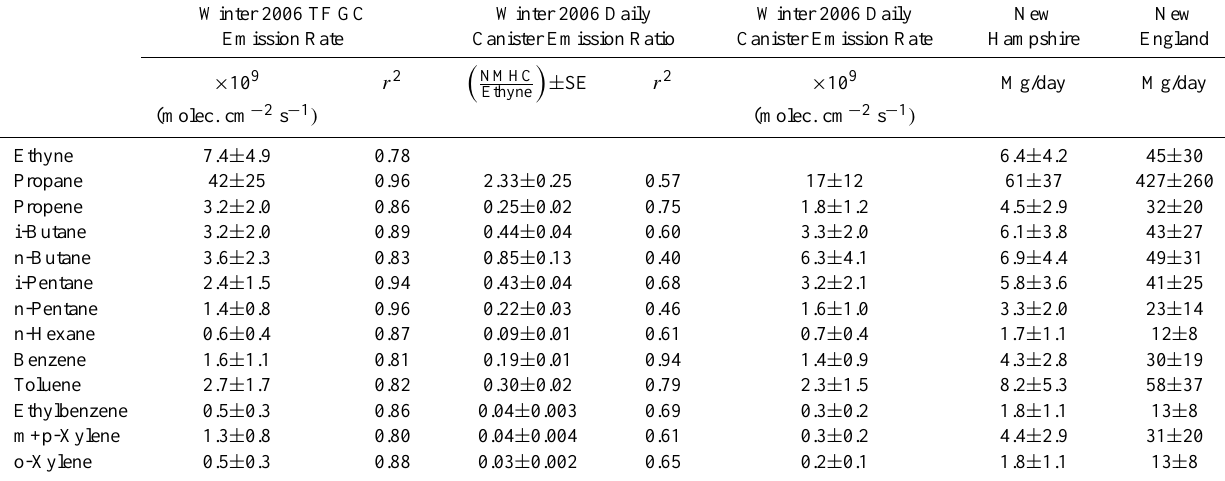
Table 3. Emission rates (moleculescm − 2 s − 1 ) of C 3 -C 8 NMHCs calculated using nighttime measurements made by the automated TF GC when a stable inversion layer developed during winter 2006. The error bars were calculated by propagating the standard error of the linear regression between the change in NMHC concentration per unit time (00:00–05:00EST) and the assumed variation in nocturnal boundary layer height (125m ± 75m). The winter 2006 daily canister emission ratio ( ± standard error (SE)) was calculated from the slope of the correlation between a NMHC and ethyne. The winter 2006 daily canister emission rate (moleculescm − 2 s − 1 ) was calculated by multiplying the daily canister emission ratios by the TF GC ethyne emission rate. The error bars were calculated by propagating the error associated with the winter 2006 TF GC ethyne emission rate and the standard error of the NMHC/ethyne emission ratio. New Hampshire (land area=2.3 × 10 10 m 2 ) and New England (land area=1.6 × 10 11 m 2 ) emissions (Mg/day) were extrapolated from the winter 2006 TF GC emission